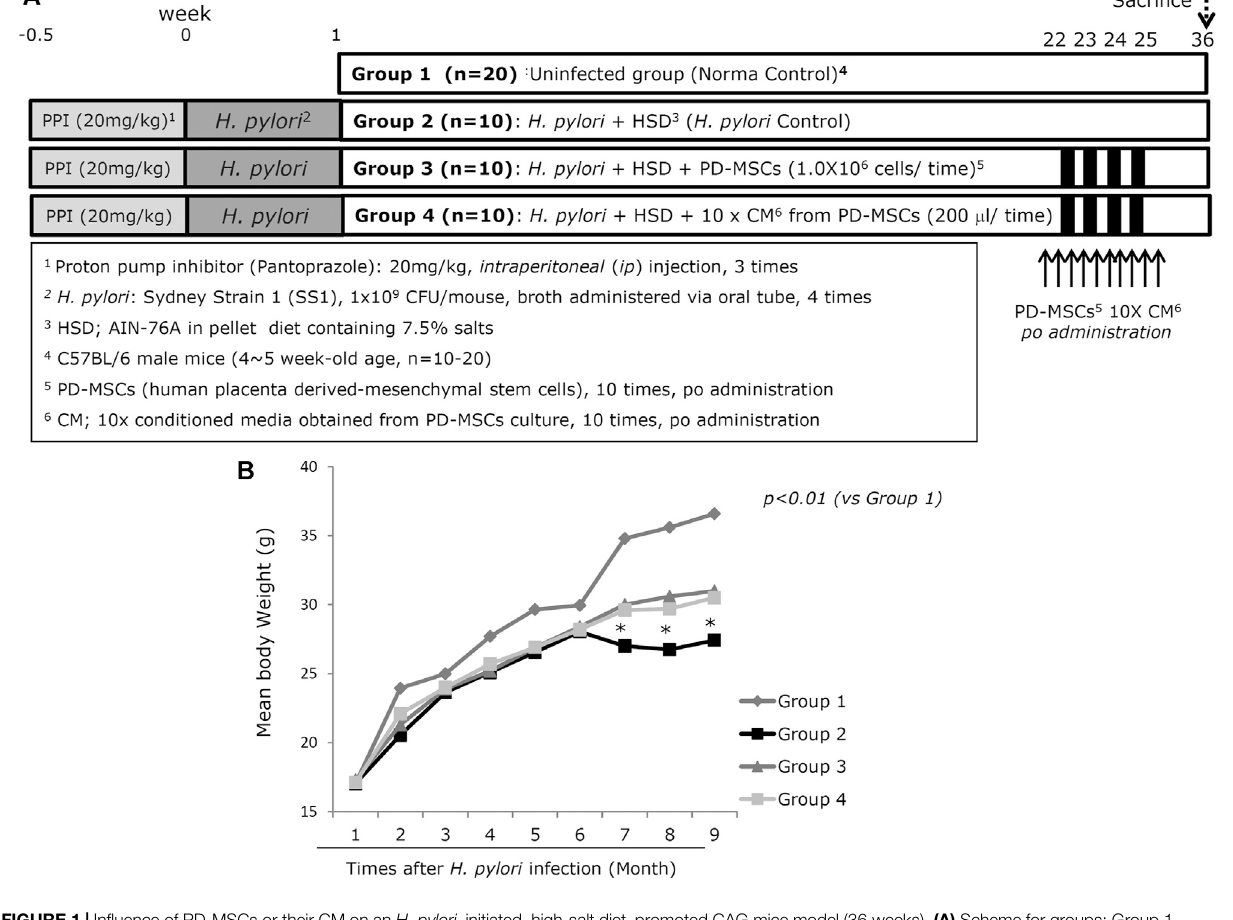
Frontiers in Pharmacology |